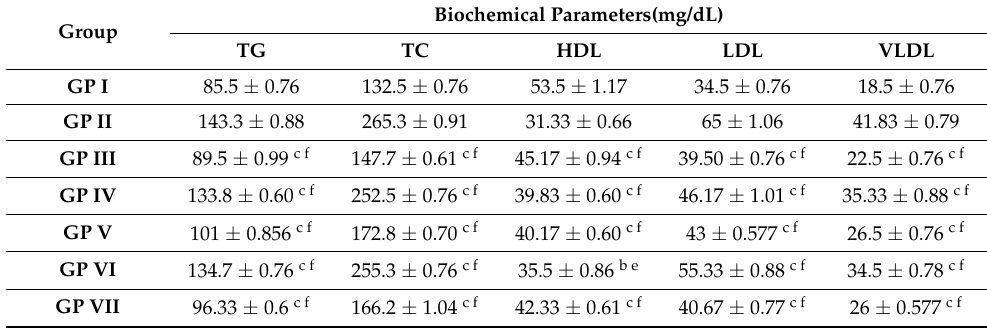
Table 3. Effect of PGE and PGAg NPs on lipid profile in STZ-induced diabetic